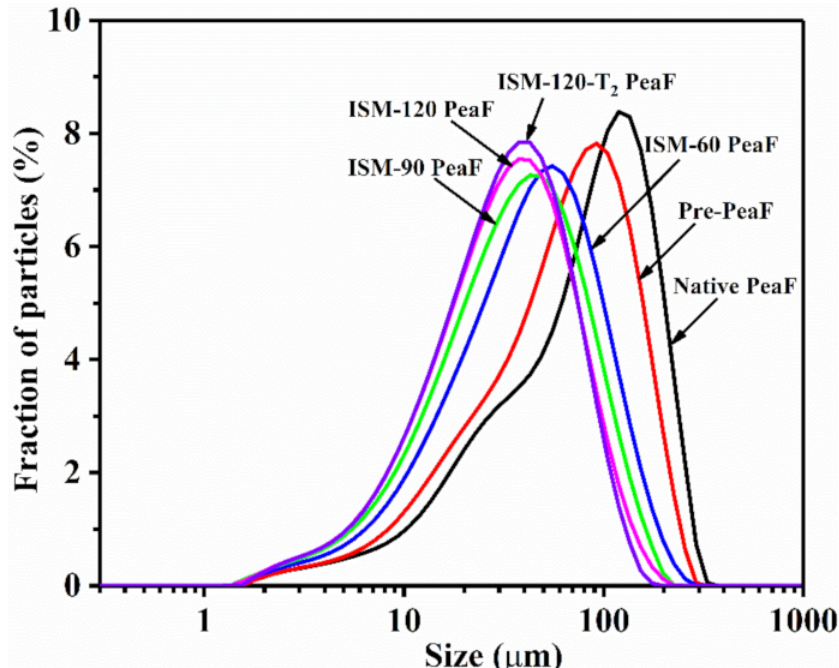
Figure 1. Particle size distributions of ISMS-treated